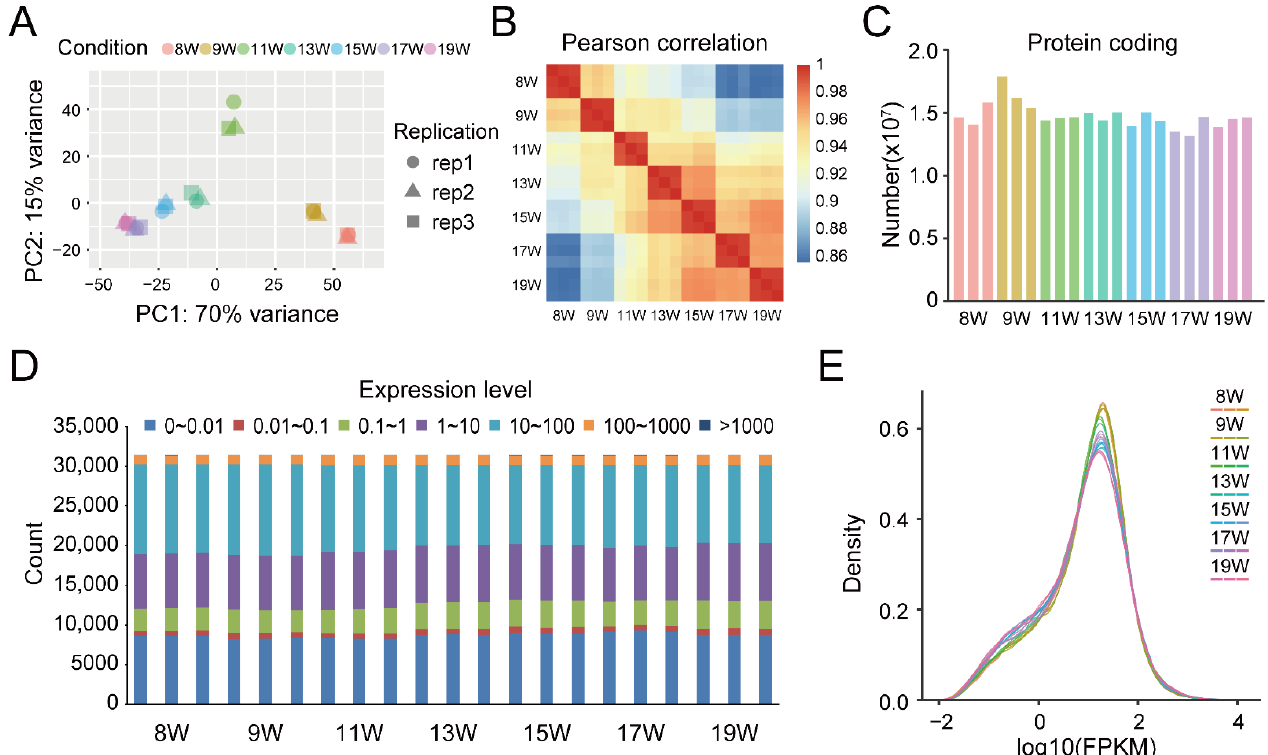
Figure 2. The profile of RNA library and sequencing. ( A ) The principal components analysis (PCA) of the sample with three biological replicates (rep), which explains 85% of the variance; ( B ) heatmap of Pearson correlation coefficients between samples, indicating a high correlation between the three biological replicates; ( C ) the number of protein-coding genes of each replicate in the samples, anno- tated by RNA-seq data; ( D ) the number of genes with different expression levels; ( E ) the density plot of sample overall gene expression level.